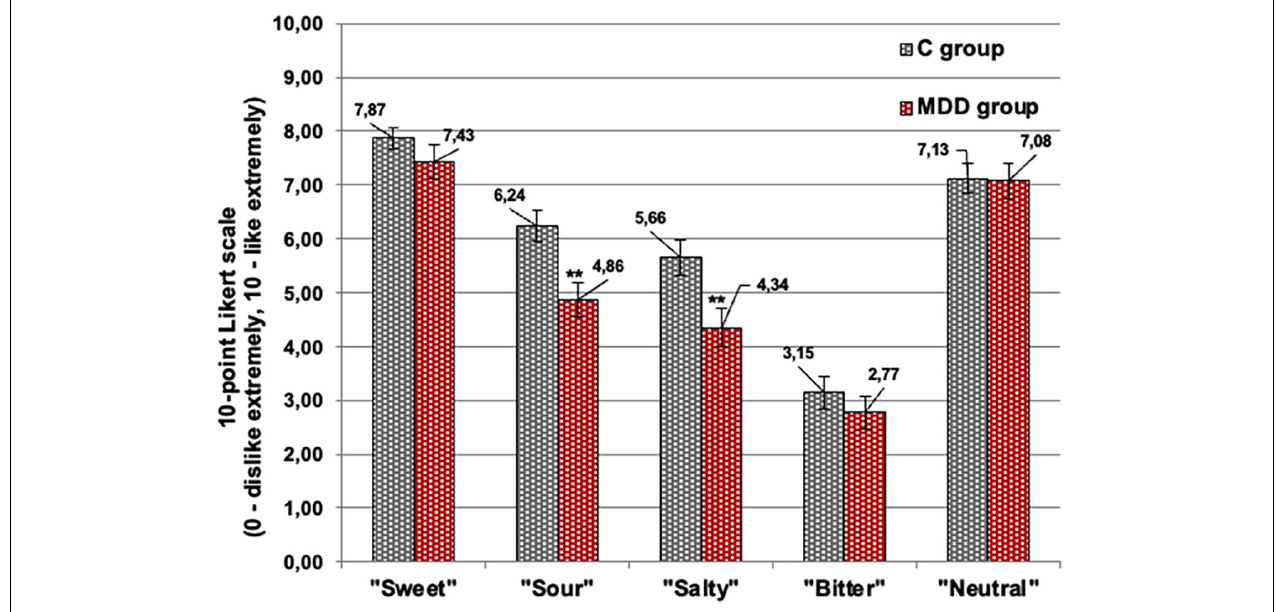
FIGURE 7 | Acceptability of the imagined different food tastes (sweet, salty, bitter, sour, and neutral) evaluated using a 10-point Likert scale (0, dislike extremely; 10, like extremely). Significant difference between groups: **p ≤ 0.01 [patients with major depressive disorder (MDD group) and without MDD (C